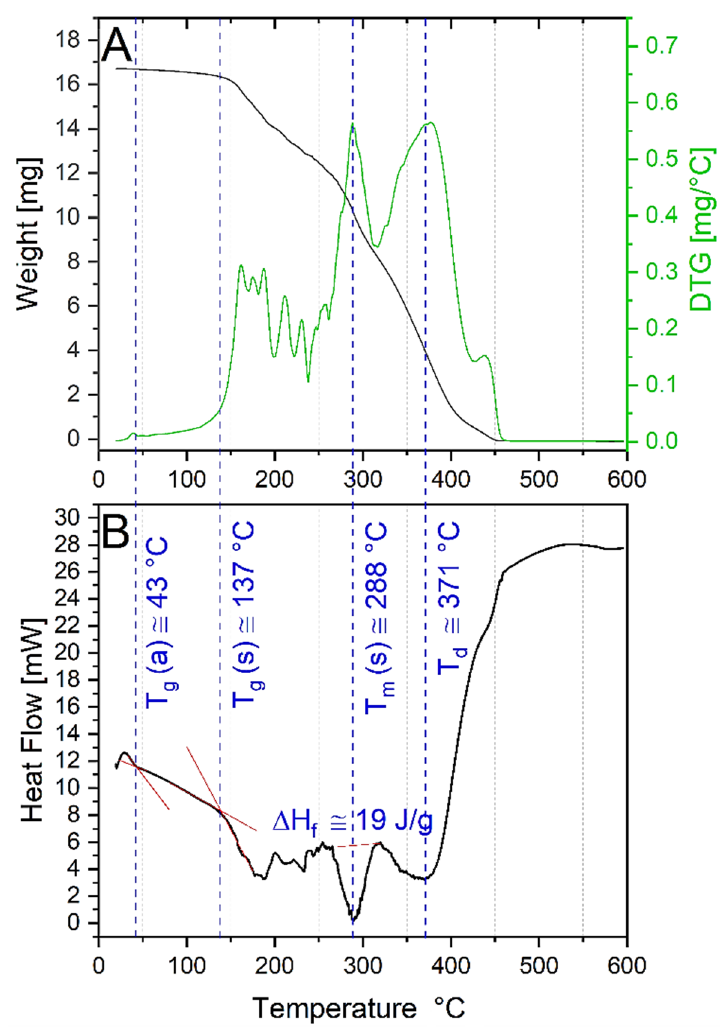
Figure 3. ( A ) Thermogravimetric analysis (TGA) curves together with derivative thermogravimetric (DTG) profiles, and ( B ) differential scanning calorimetry (DSC) of the PEMA synthetized by using the biobased succinyl peroxide as a polymeric agent. Blue dotted lines represent the glass transition temperatures (T g ), melting temperature (T m ), and decomposition temperature (T d ). Table 1. Formulation of epoxidized soybean oil paste as cross-linking agent for unsaturated polyester